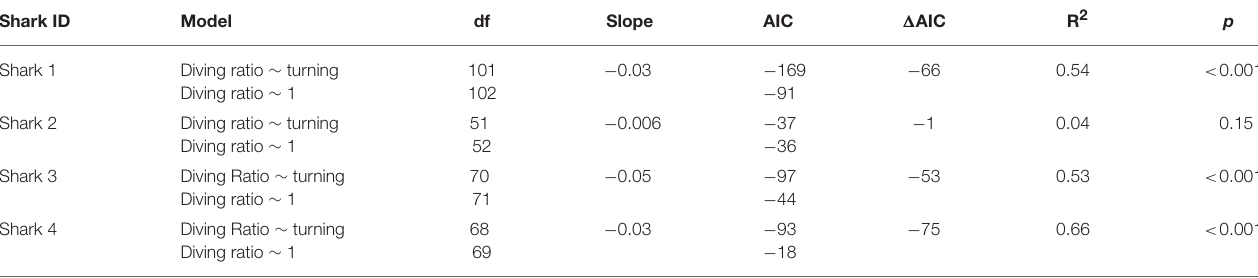
TABLE 4 | Linear model comparisons using Akaike’s Information Criterion (AIC), R 2 , and p -values.